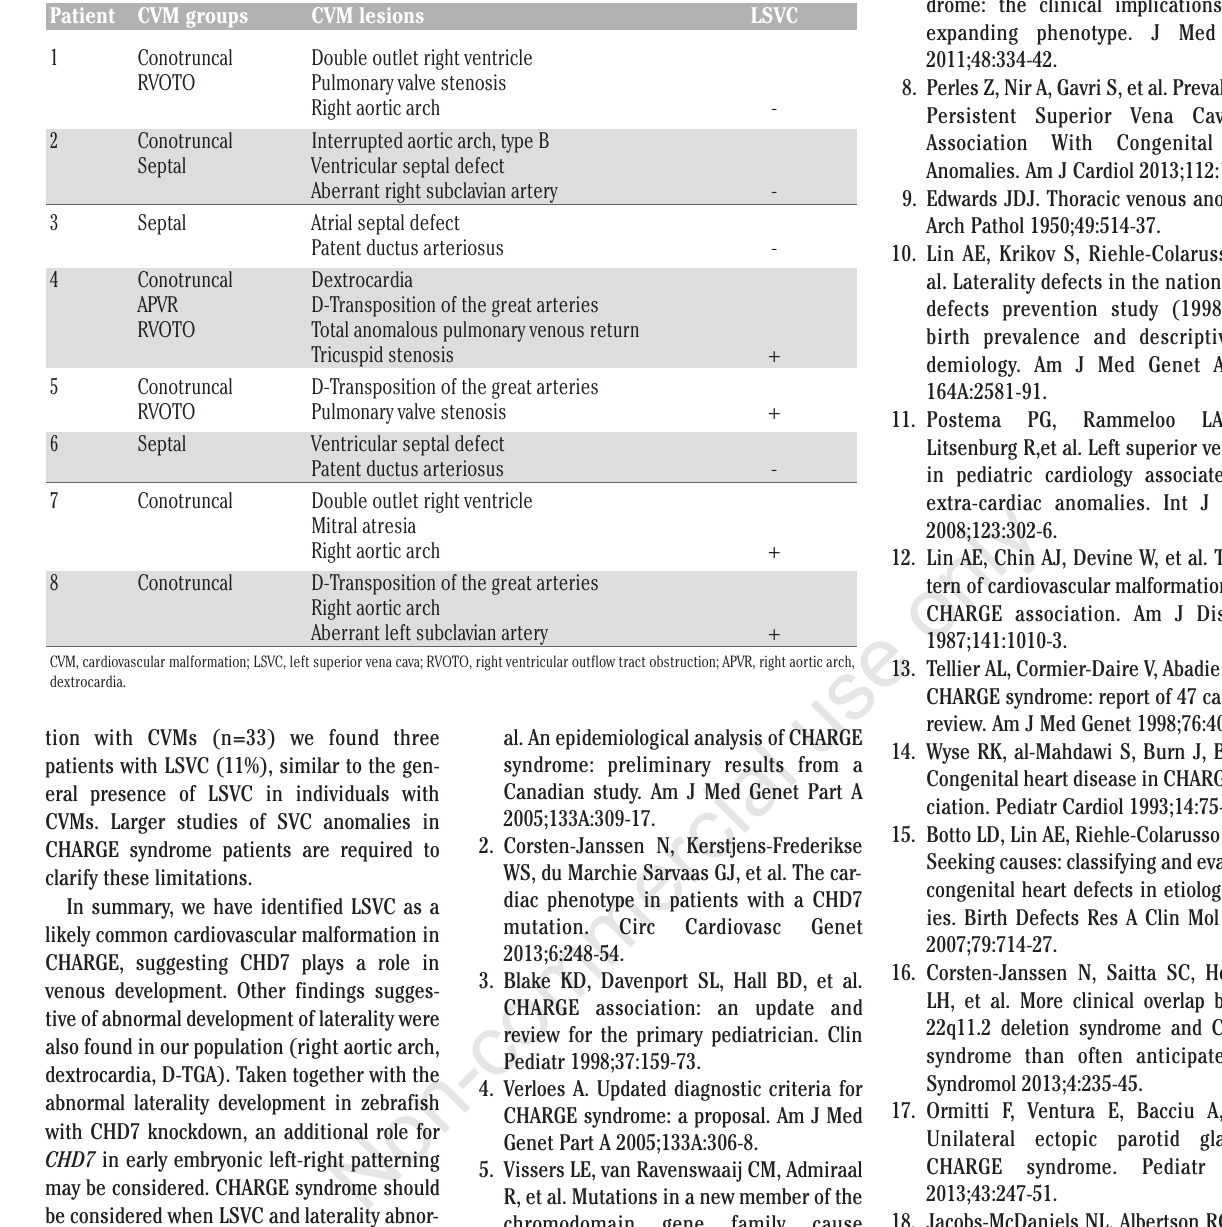
Table 3. Cardiovascular malformation and left superior vena cava